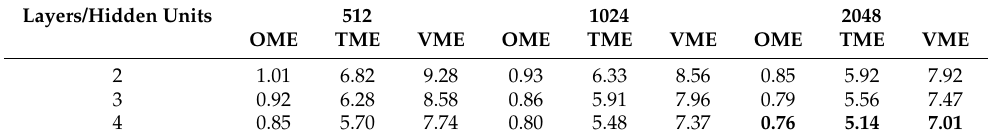
Table 5. Ablation results for GRU structure on Human3.6M. The best results are shown in bold. Layers/Hidden Units